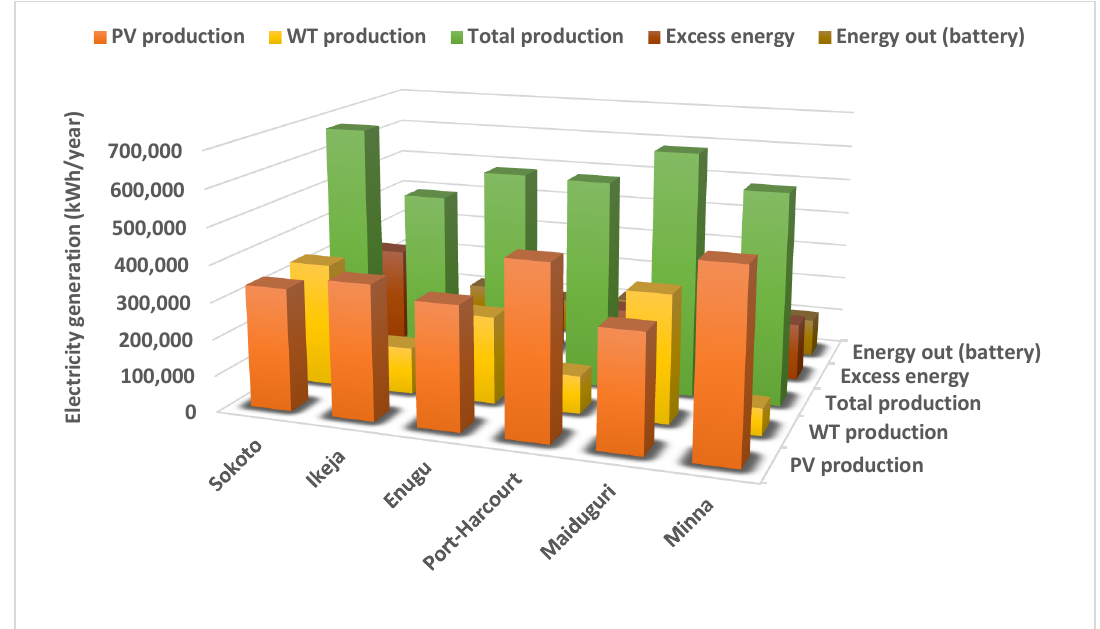
Figure 8. Yearly electric generation of the optimal charging station schemes (PV/WT/battery) in the considered locations.